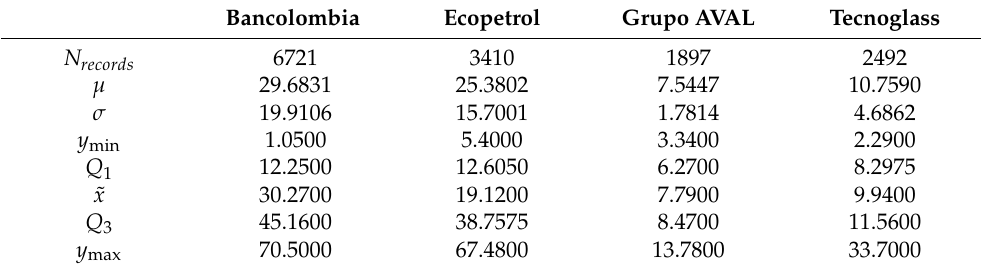
Table 1. Descriptive parameters for each share’s closing price: Bancolombia, Ecopetrol, Grupo AVAL, and Tecnoglass.